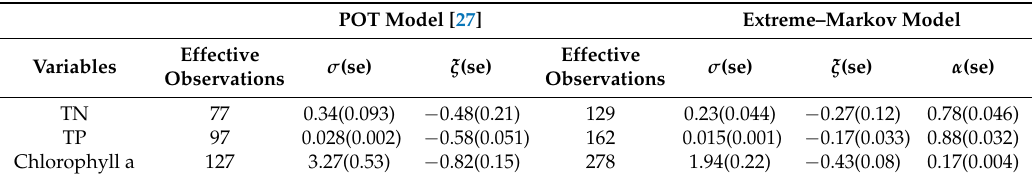
Table 2. Comparison of the parameters between the peak over threshold (POT) and Markov–Extreme model results.